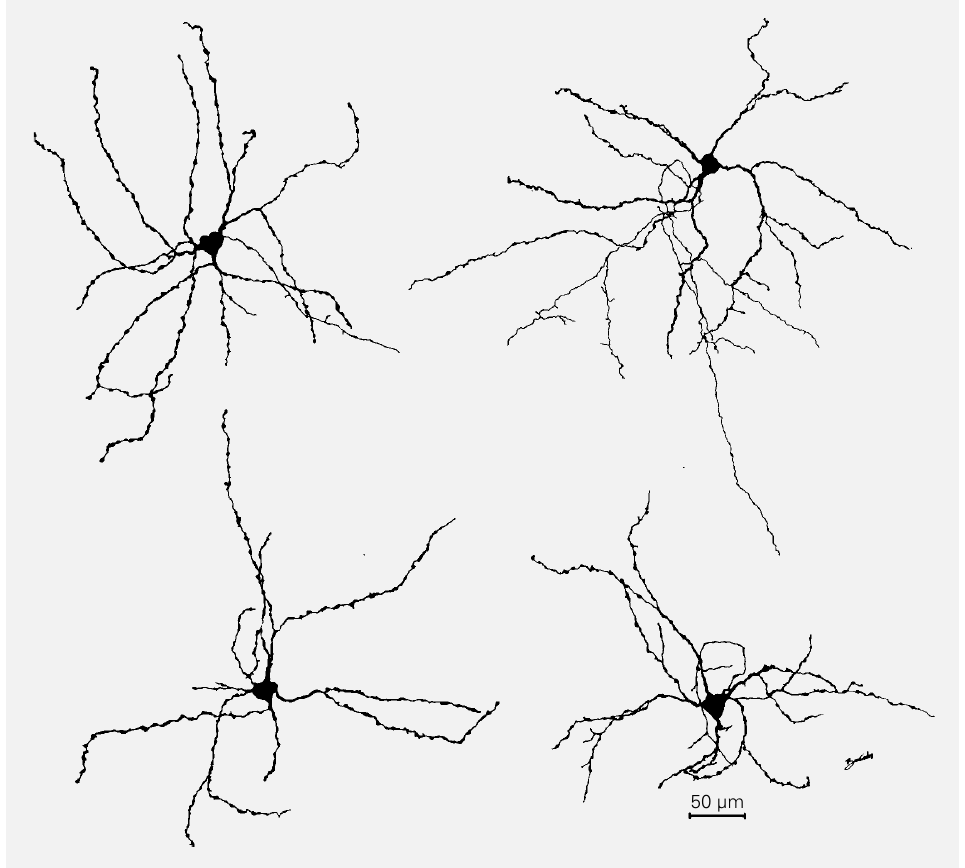
Figure 7 - Camera lucida draw- ings of four representative white matter neurons obtained in a tangential